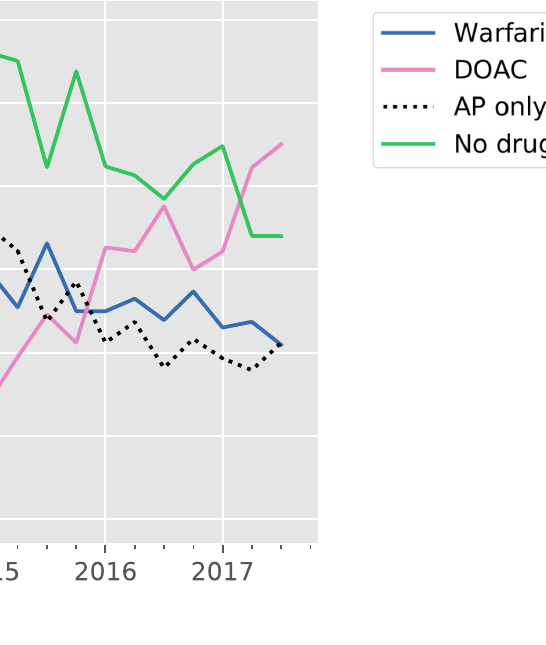
PLOS ONE | https://doi.org/10.1371/journal.pone.0225625 November25,